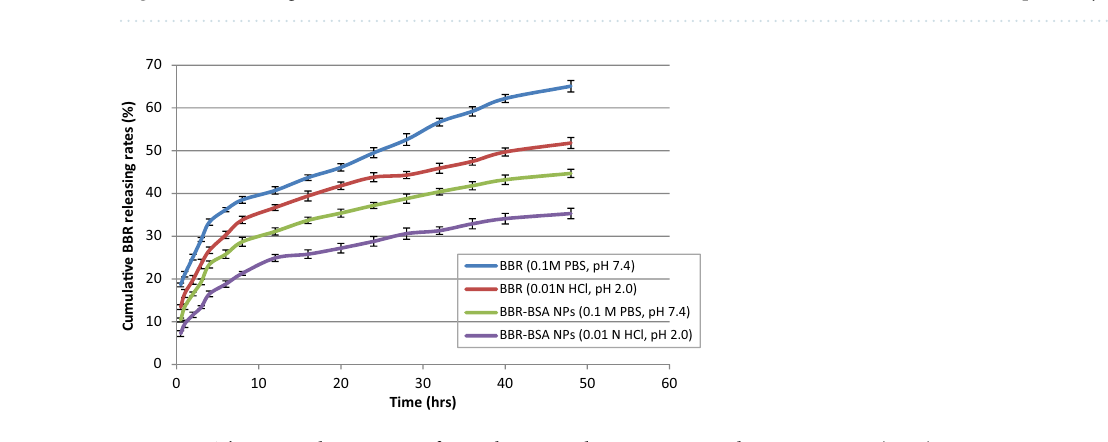
Figure 4. Thermograms of standard BBR-chloride and BBR-BSA NPs DTA ( a , c ), and DSC ( b , d ), respectively.